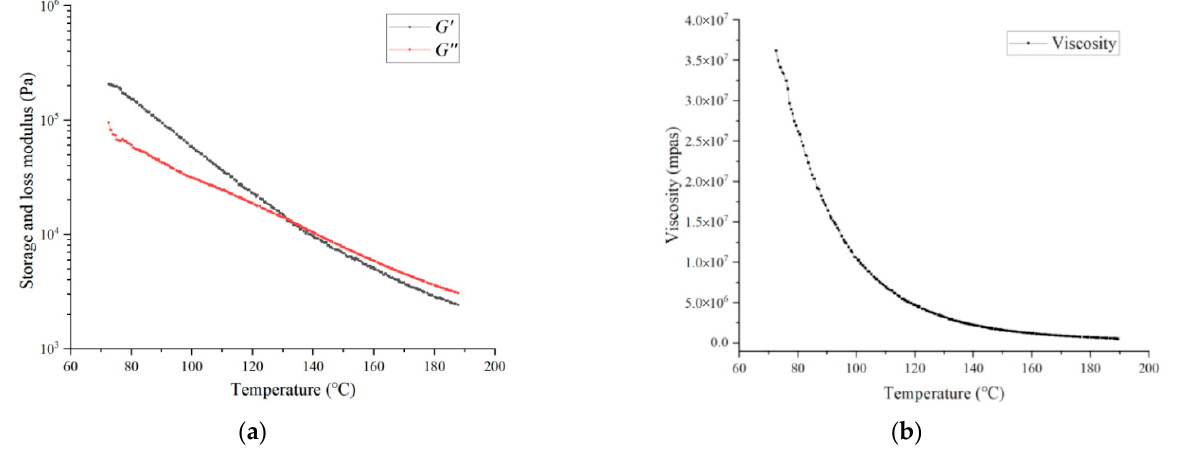
Figure 8. ( a ) Storage and loss modulus of PLCL with various temperatures; ( b ) viscosity curves of PLCL with various temperatures.